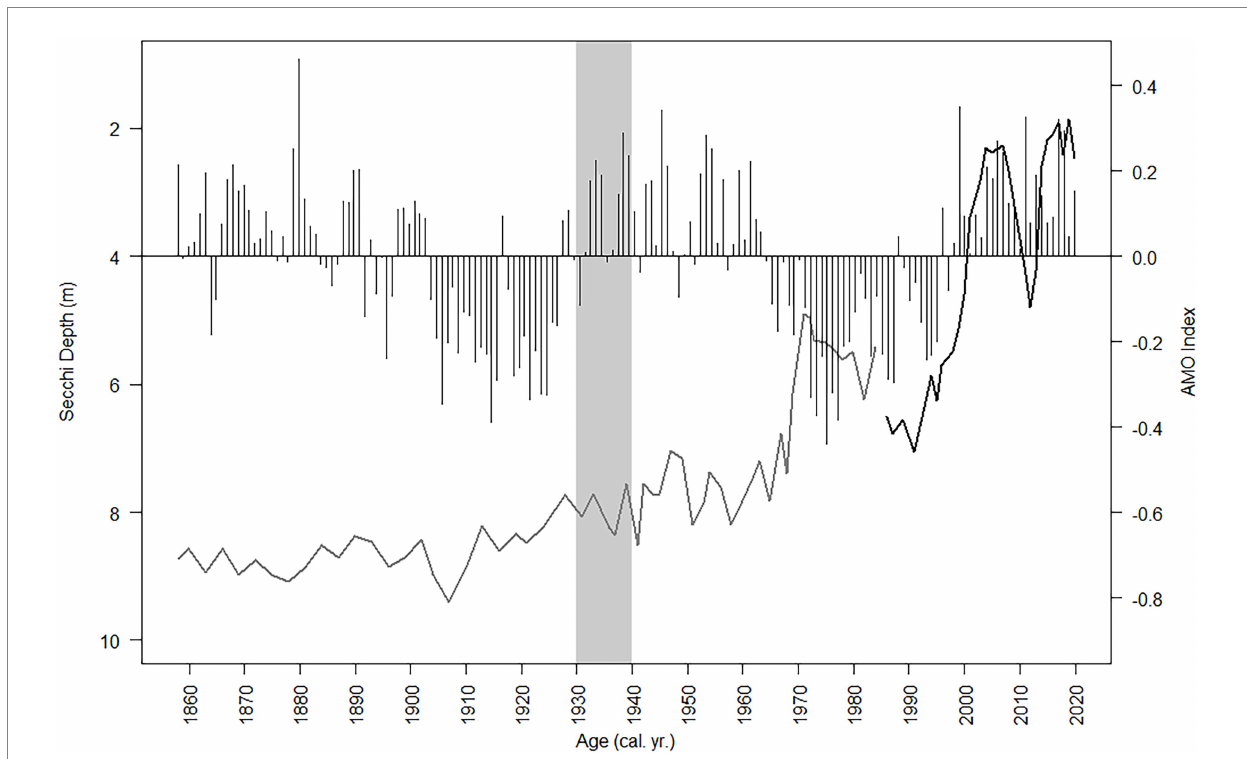
FIGURE 12 Secchi depth (observed and diatom-inferred, black line and gray line respectively) and the NOAA AMO index oscillation (black bars) from 1856 to 2019. The gray bar is when the two ditches were dredged near Lake Annie (estimated between 1930 and